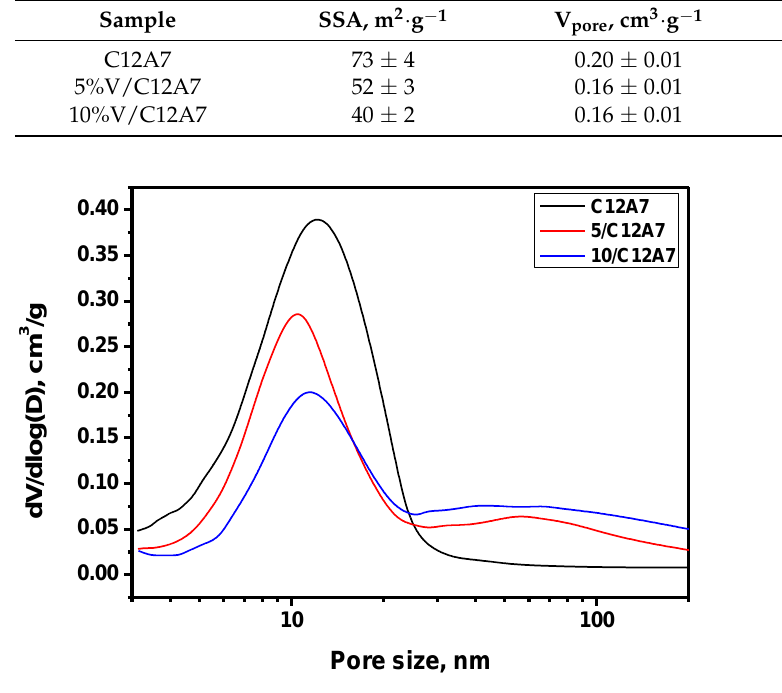
Figure 2. Pore size distributions for C12A7, 5%V/C12A7, and 10%V/C12A7 samples.